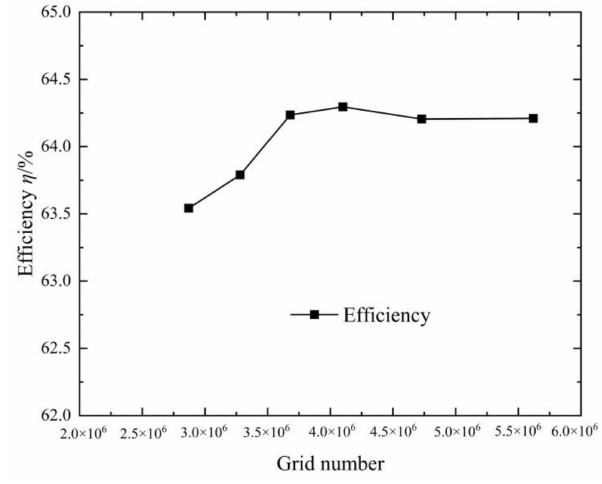
Figure 7. Efficiency-based grid independence verification.